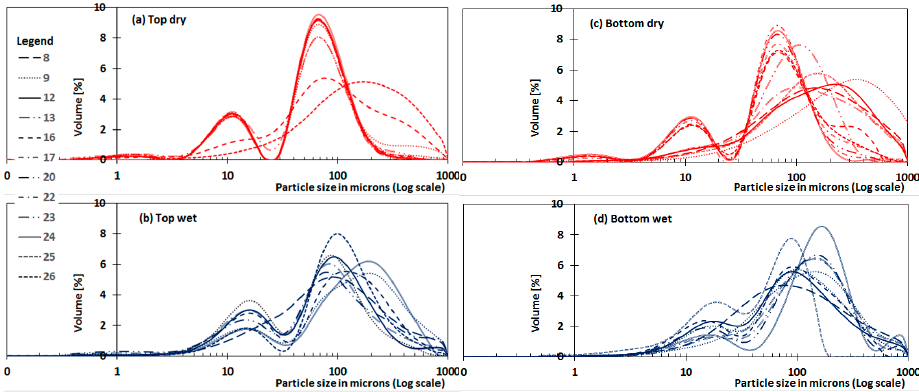
Figure 3. Particle size distribution for top and bottom samples collected inside the pond (node numbers shown in the legend); ( a , c ) Dry weather top and bottom respectively. ( b , d ) Wet weather top and bottom respectively.